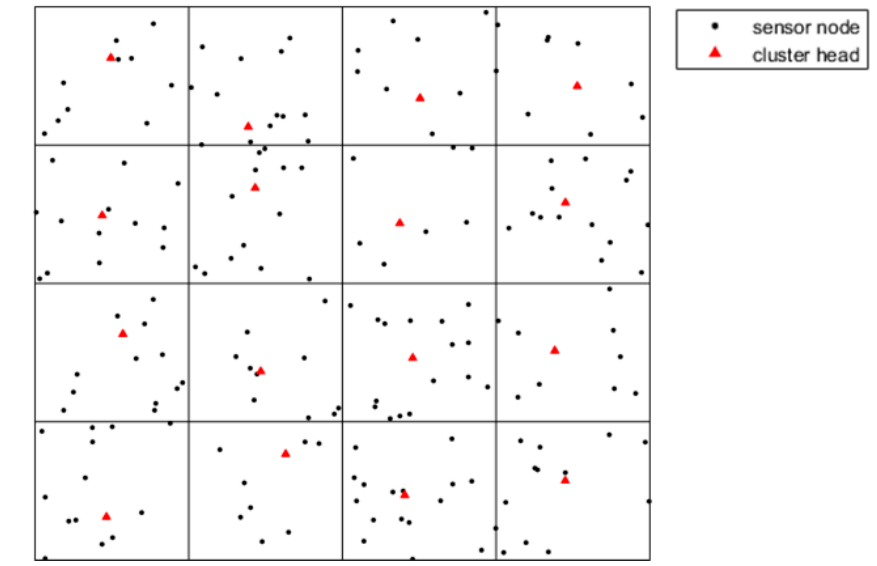
Figure 5. The sensor field after clustering.